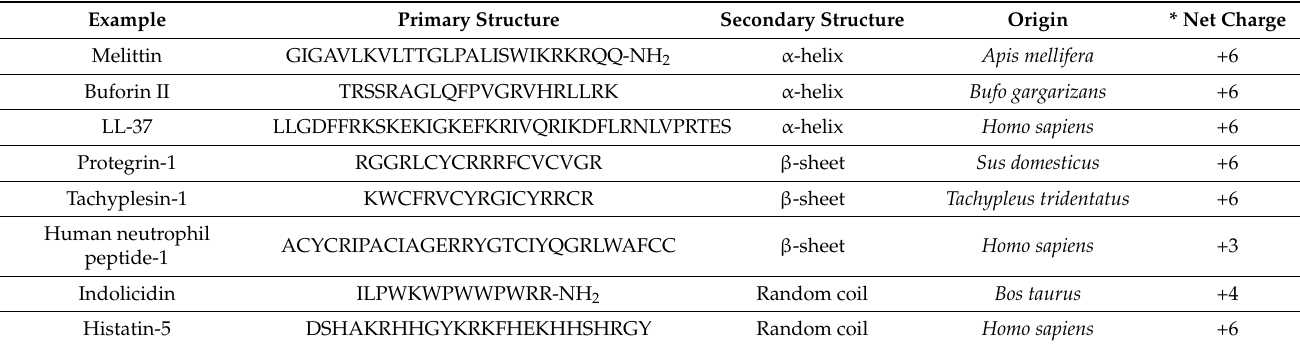
Table 1. Representative examples of naturally occurring AMPs. Secondary structure refers to the observed structure in membrane-mimetic environments. * Net charge calculated at physiological pH (pH = 7.4). While some of the AMPs contain anionic residues, they display a net positive